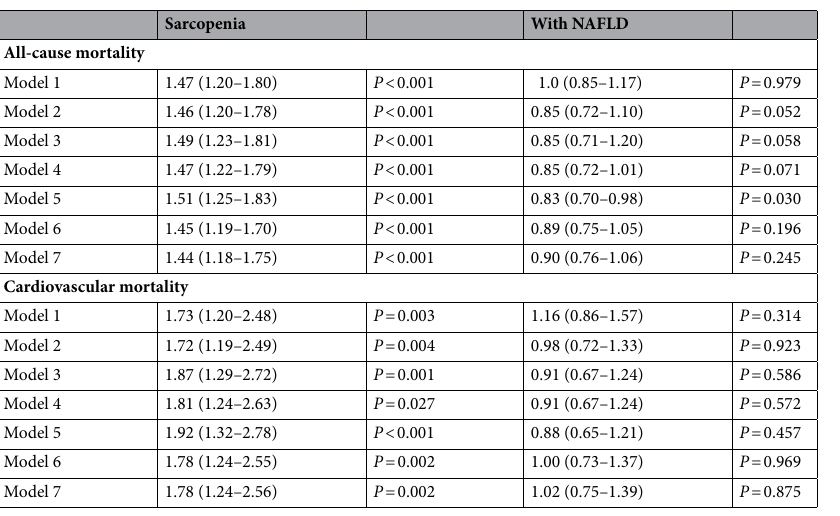
Table 2. Hazard ratios (with 95% confidence intervals) for sarcopenia- or nonalcoholic fatty liver disease (NAFLD)-related risks of all-cause and cardiovascular mortality. To assess the hazard ratios (with 95% confidence intervals) for sarcopenia-related risks of all-cause and cardiovascular mortality, subjects without sarcopenia were served as the reference group. To assess the hazard ratios (with 95% confidence intervals) for NAFLD-related risks of all-cause and cardiovascular mortality, subjects without NAFLD were served as the reference group. Model 1 was adjusted for age, gender, race-ethnicity, and education level. Model 2 was adjusted for smoking and drinking status, body mass index, hypertension, and diabetes in addition to the factors included in model 1. Model 3 was adjusted for total cholesterol, triglyceride, and HDL-cholesterol in addition to the factors included in model 2. Model 4 was adjusted for C-reactive protein in addition to the factors included in model 3. Model 5 was adjusted for HOMA-IR in addition to the factors included in model 3. Model 6 was adjusted for comorbid conditions such as stoke, coronary heart disease, and chronic obstructive pulmonary disease in addition to the factors included in model 3. For analysis of sarcopenia-related risks of all-cause and cardiovascular mortality, model 7 was adjusted for all the variables in model 6 plus NAFLD. For analysis of NAFLD-related risks of all-cause and cardiovascular mortality, model 7 was adjusted for all the variables in model 6 plus sarcopenia.